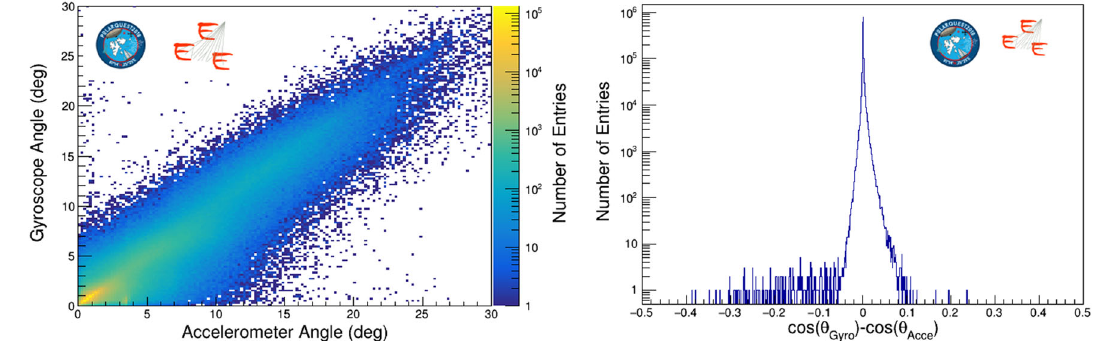
Fig. 18 Left: Correlation between the zenith angle measured with the gyroscope and by the accelerometer in POLA-01. Right: Distribution of the difference of the cosines of the two angles measured by the gyroscope and the accelerometer mounted on POLA-01